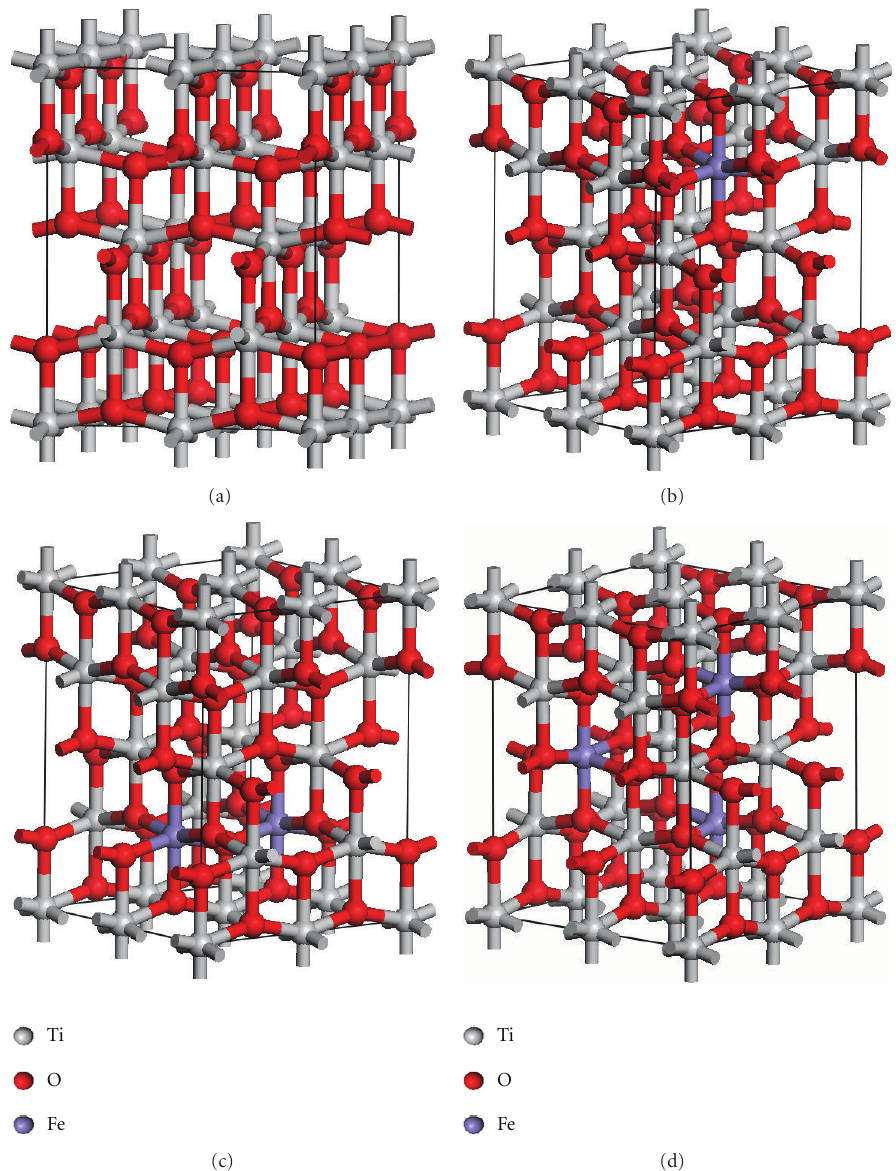
Figure 1: 2 × 2 × 1 anatase TiO 2 supercell models with various concentrations of Fe: (a) pure TiO 2 , (b) 2.08 at.%, (c) 4.17 at.%, (d) 6.25